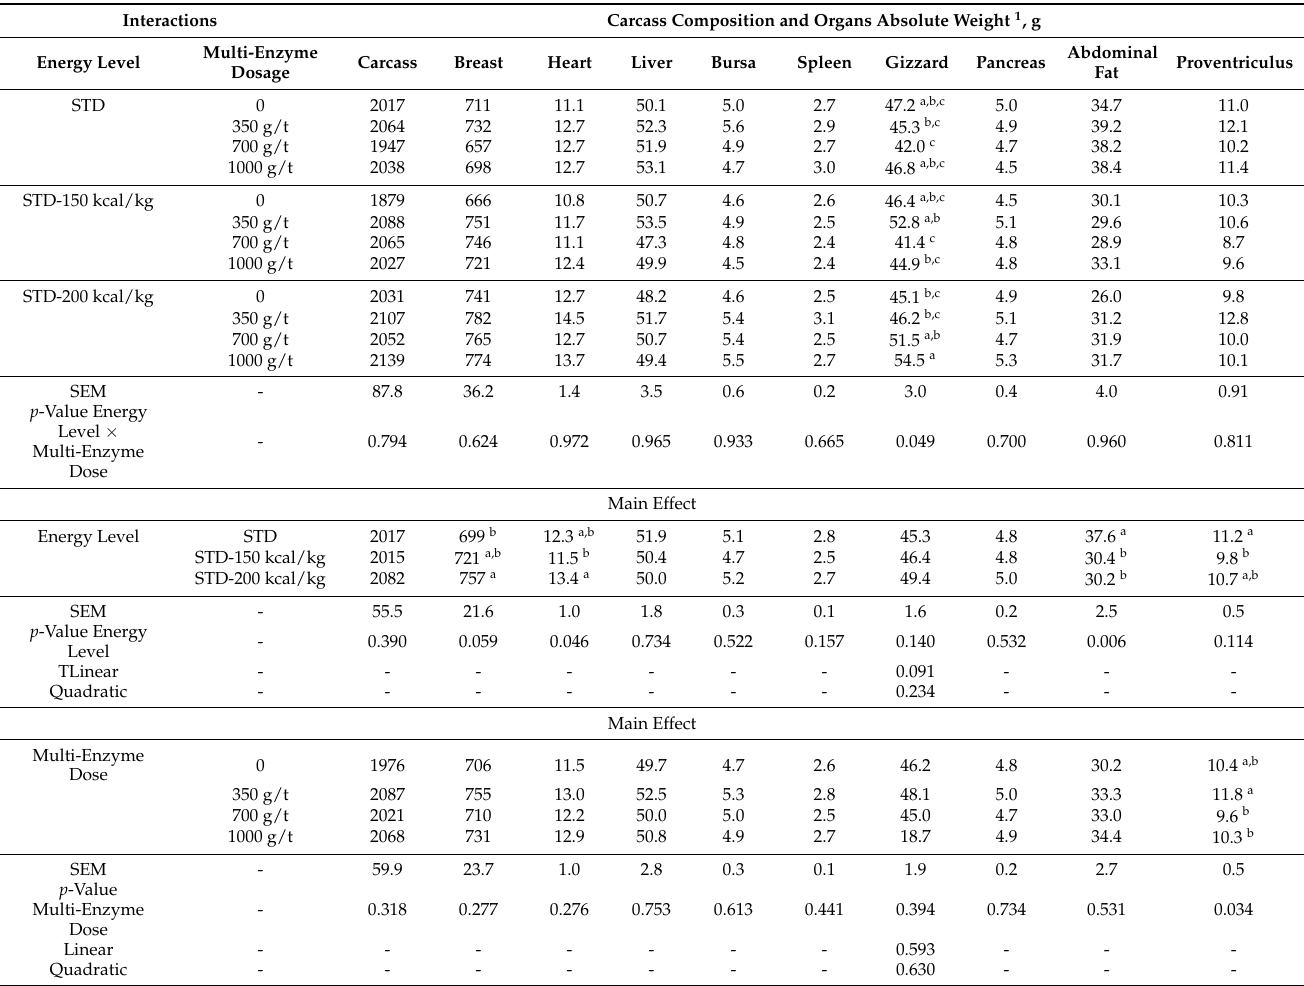
by the multi-enzyme dose rates or the interaction. Table 4. Effects of multi-enzyme super-dosing in reduced energy diets on broiler chicken organ development. Interactions Carcass Composition and Organs Absolute Weight 1 , g Energy Level Bursa Spleen Gizzard Pancreas Abdominal Fat